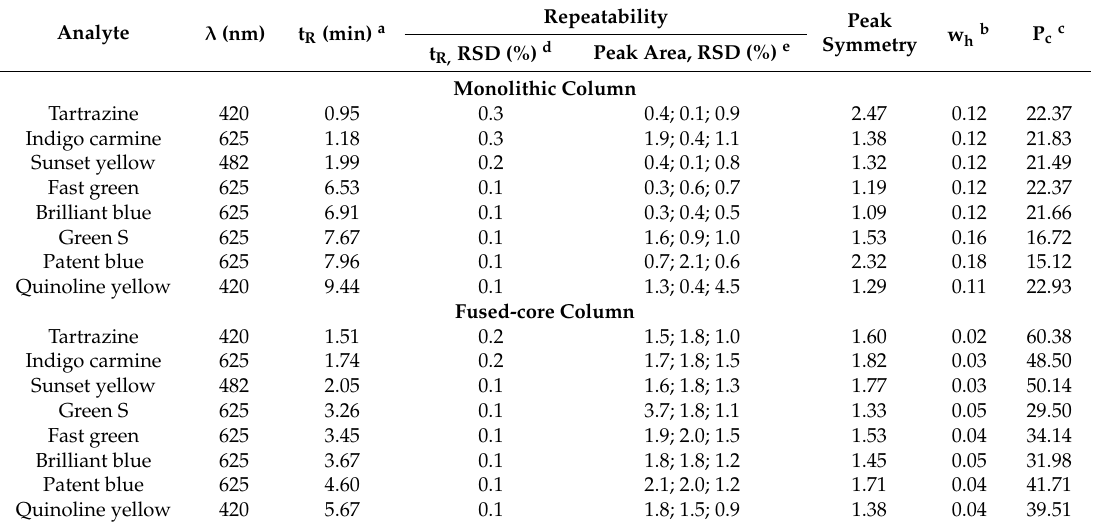
Table 1. System suitability test results.